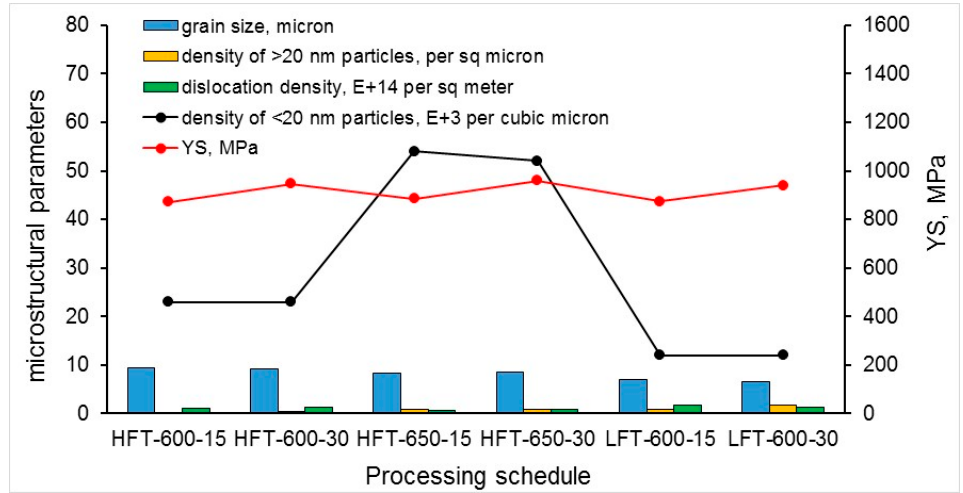
Figure 10. Variations in microstructural parameters and the yield stress with processing schedule.